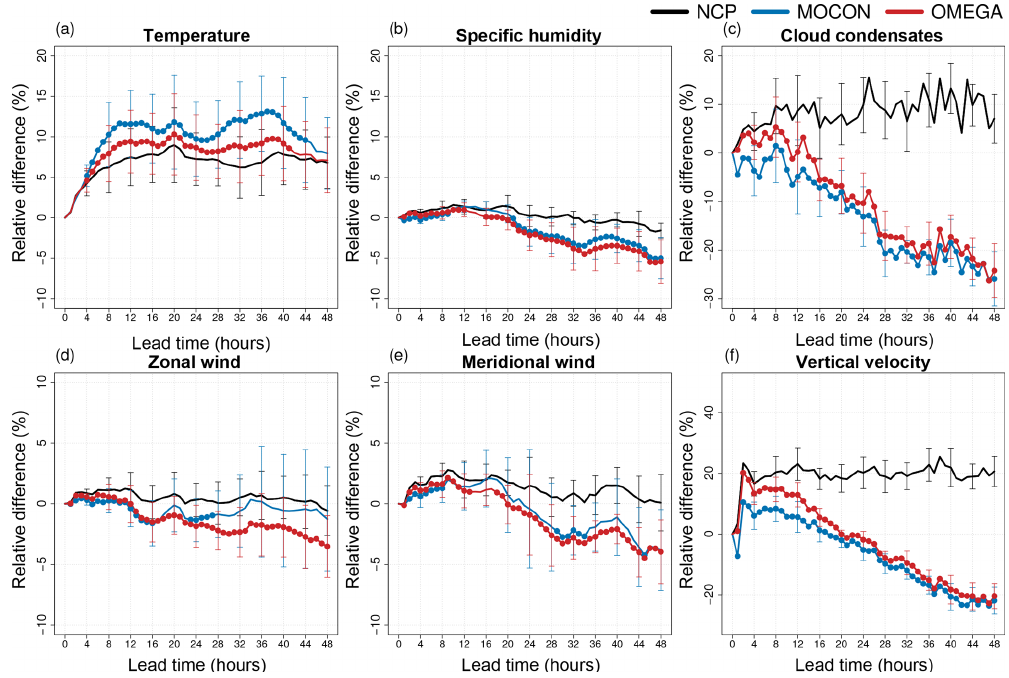
Figure 11. Same as Fig. 10 but for the 850hPa